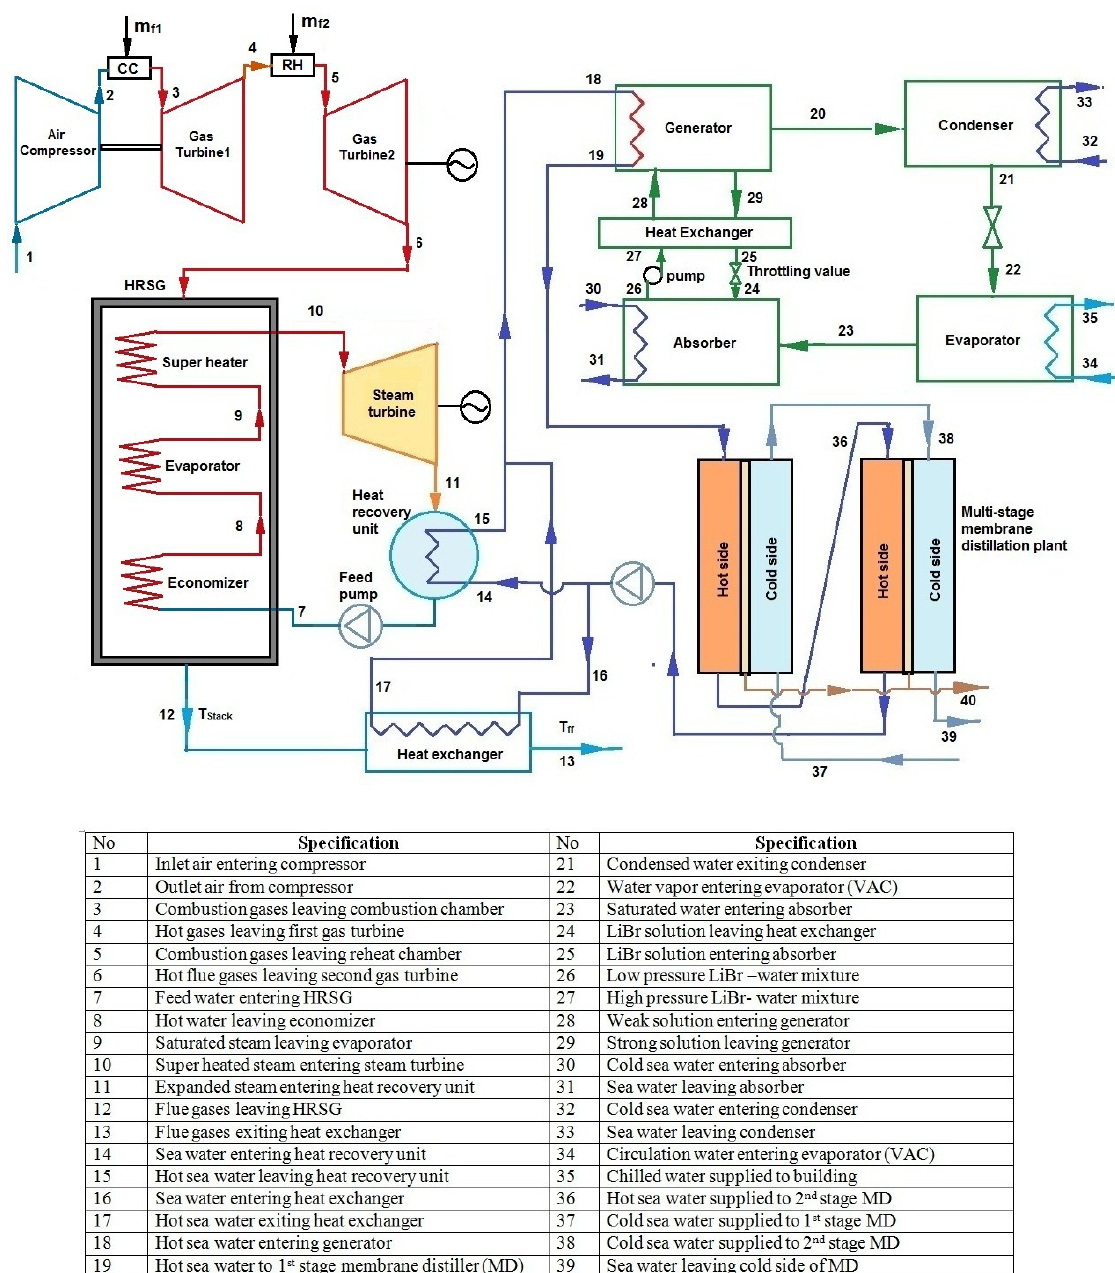
Figure 2. Schematic layout of tri-generation